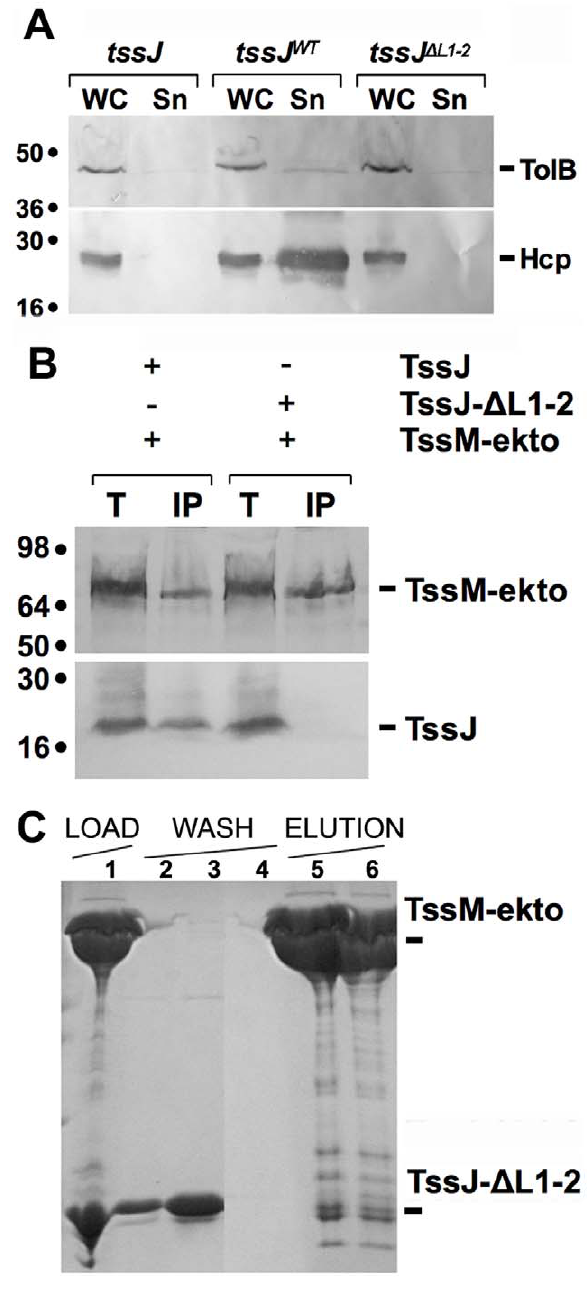
Figure 4. The L1-2 loop of TssJ is required for TssJ-TssM complex formation. ( A ) In vivo Hcp release assay. Hcp FLAG release was assessed by separating whole cells (WC) and supernatant (Sn) fractions from tssJ cells carrying the empty vector ( tssJ ), the vector encoding wild-type TssJ ( tssJ WT ) or the vector encoding the TssJ- D L1-2 mutant ( tssJ D L1-2 ). 2 6 10 8 cells and the TCA-precipitated material of the supernatant from 5 6 10 8 cells were loaded on a 12.5%-acrylamide SDS- PAGE and immunodetected using the anti-FLAG monoclonal antibody (lower panel) and the anti-TolB polyclonal antibodies (lysis control; upper panel). ( B ) Solubilized extracts of E. coli K12 W3110 strain producing ( + ) or not (-) FLAG-tagged TssM-ekto and HA-tagged TssJ or TssJ- D L1-2 mutant were subjected to immunoprecipitation with anti- FLAG-coupled beads. The total solubilized material (T) and the immunoprecipitated material (IP) were loaded on a 12.5%-acrylamide SDS PAGE, and immunodetected with anti-HA (TssJ and TssJ- D L1-2; lower panel) and anti-FLAG (TssM-ekto; upper panel) monoclonal antibodies. Immunodetected proteins are indicated on the